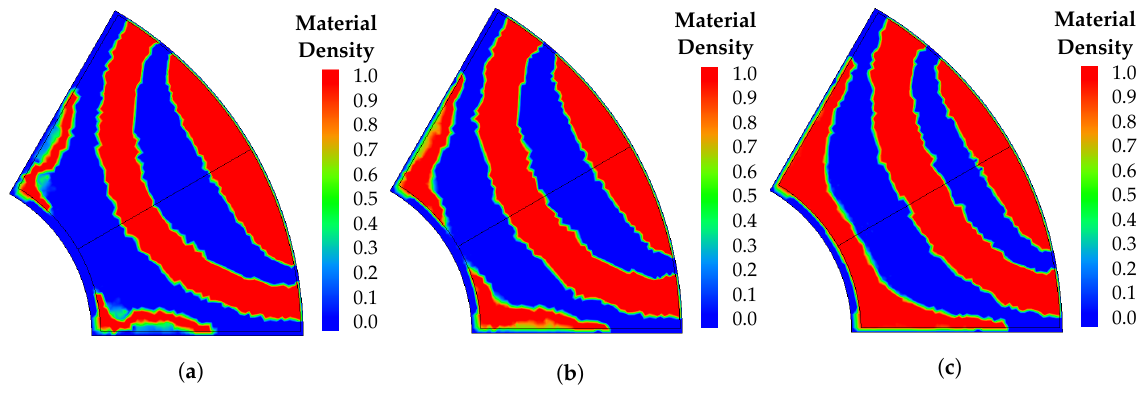
Figure 7. Material density distributions, with initial density of: ( a ) 0.2, ( b ) 0.5, ( c )